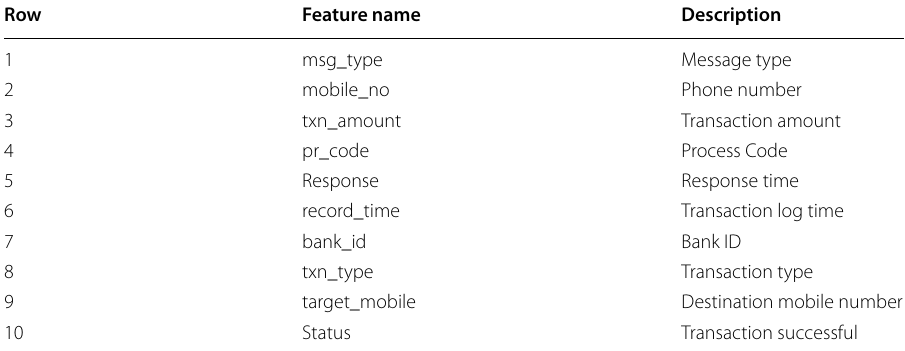
Table 10 Effective characteristics of basket analysis by the N-LIST algorithm